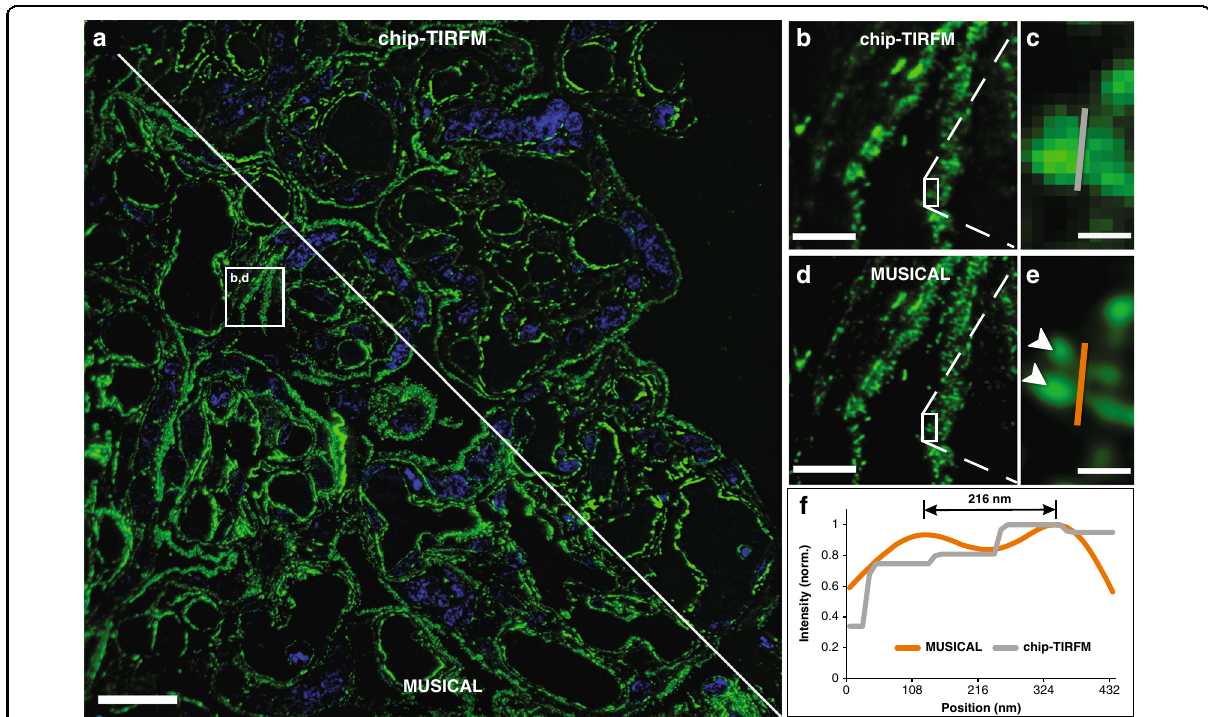
Fig. 4 Chip-based intensity fl uctuation optical nanoscopy of a 400 nm thick placental tissue section prepared per Tokuyasu method. F-actin labeled with Phalloidin-Atto565 (pseudo-colored in green) and nuclei labeled with Sytox Green (pseudo-colored in blue). a Multicolor fl uorescent image over a 220 µm × 220 µm FOV acquired with a 60x/1.2NA microscope objective. A solid white line divides the image into two segments, illustrating the averaged chip-TIRFM on the top and the MUSICAL reconstruction at the bottom. b , d A magni fi ed view of the white box in ( a ) allows for visualization of the microvilli (MV) lining the syncytiotrophoblast ’ s brush border. c Further magni fi cation of the white box in ( b ) shows a single structure. e White arrowheads denote the location of two adjacent MV over the magni fi ed white box in ( d ). f Line-pro fi le measurements reveal a separation of 216 nm between two adjacent MV on the MUSICAL reconstruction in ( e ) that is otherwise not distinguishable on the averaged chip- TIRFM image in ( c ). Scale bars a 25 µm, b , d 5 µm, and c , e 500 nm. The MUSICAL image was adjusted with a logarithmic transformation in FIJI to improve its